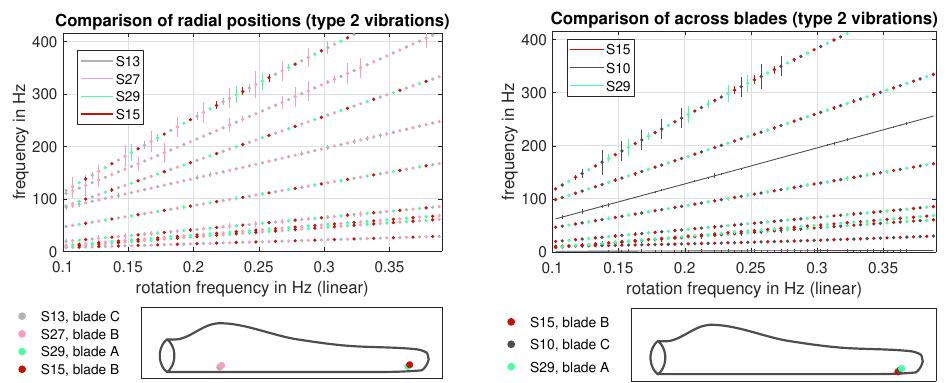
Figure 14. ( Left ) Fingerprint comparison for Sensors S 13, S 27, S 29 and S 15 with varying radial positions on Turbine 2. ( Right ) Fingerprint comparison for sensors mounted on the blade tips of all three blades of Turbine 2 ( S 15, S 10 and S 29). Solid lines represent vibrations only occurring in the fingerprint of one sensor, dotted multi-coloured lines represent vibrations occurring jointly in multiple fingerprints. Error bars show locations of associated peaks with their length representing peak